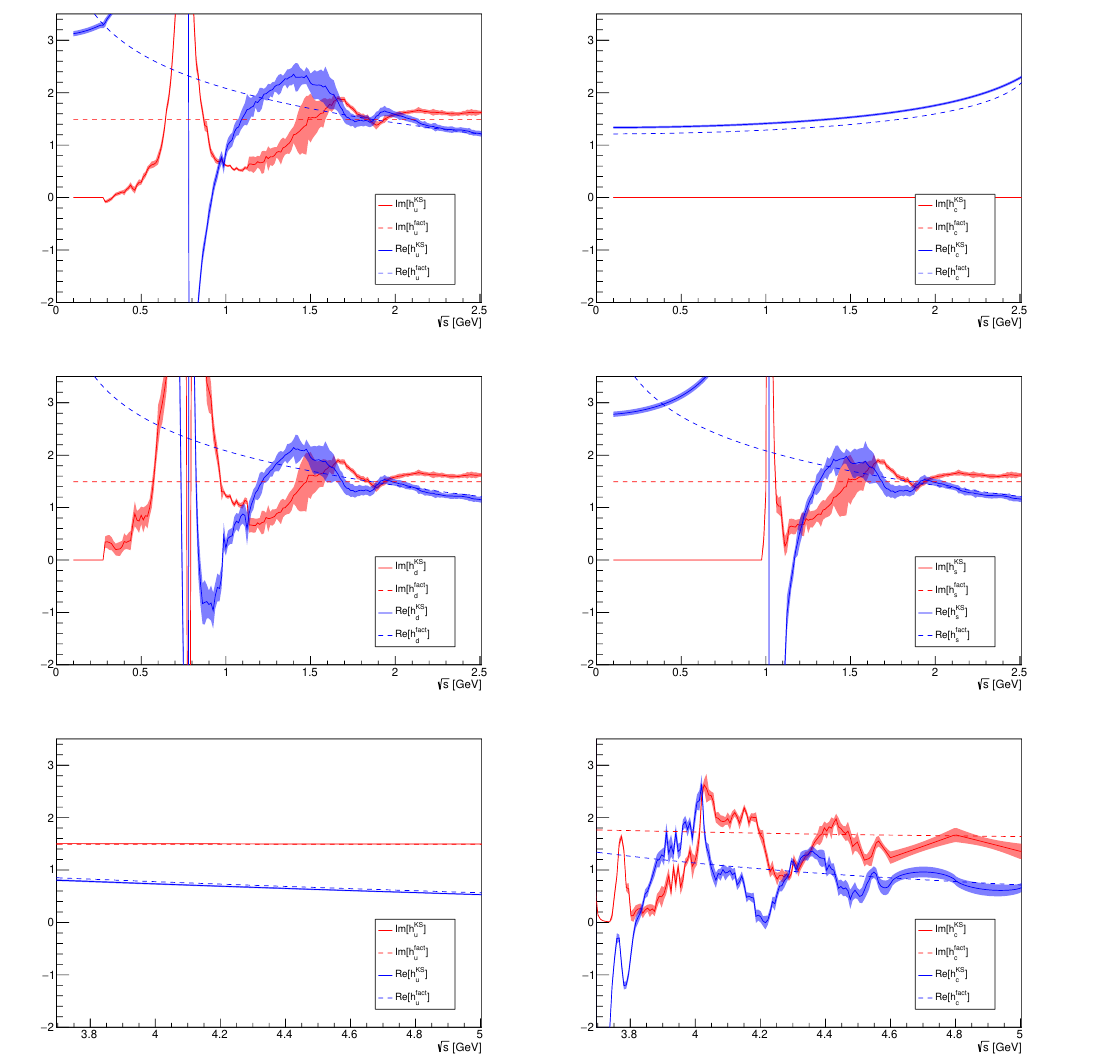
Figure 5 . KS functions and the corresponding perturbative functions to two loops in the low- and high- q 2 region. See text for further